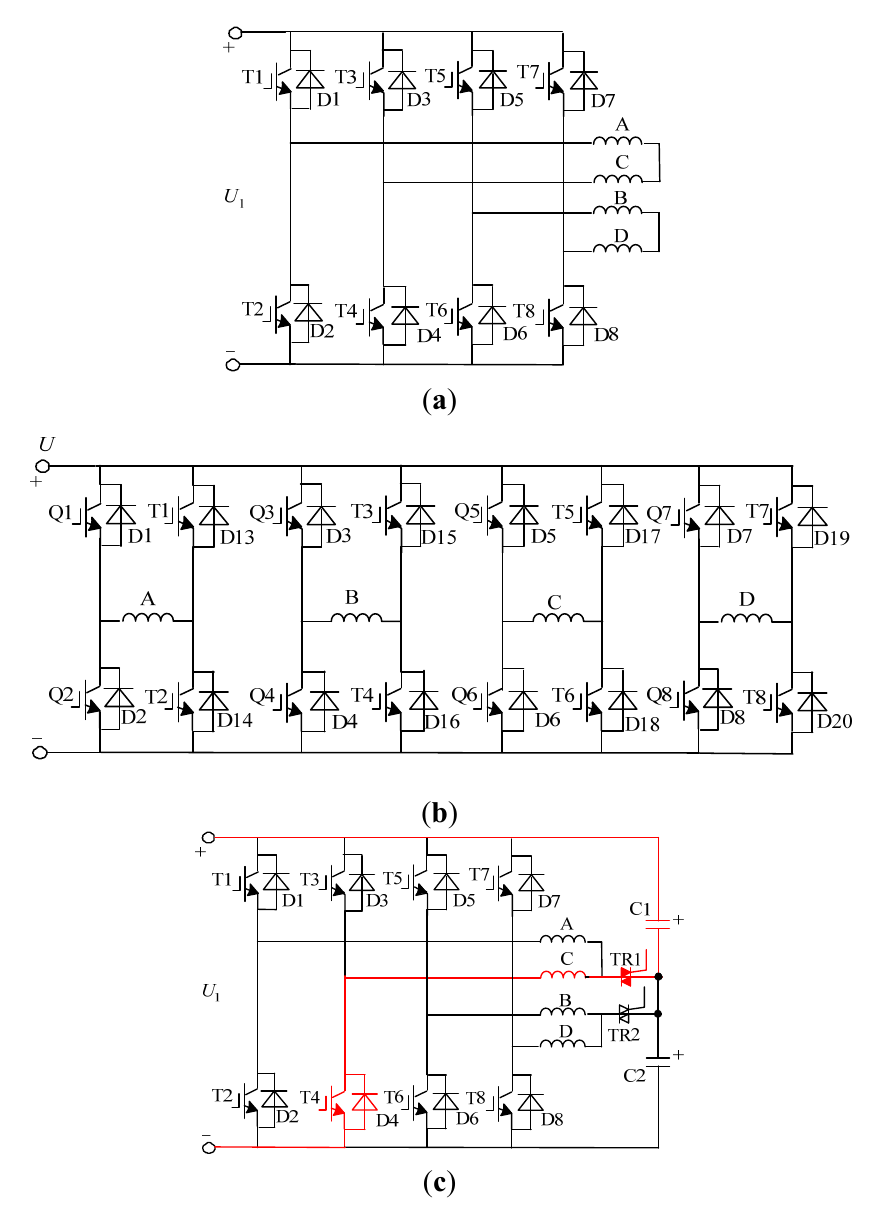
Figure 10. Comparison of the four-phase fault-tolerant converter. ( a ) The traditional four-phase converter; ( b ) The four-phase H bridges converter; ( c ) The half bridge four-phase